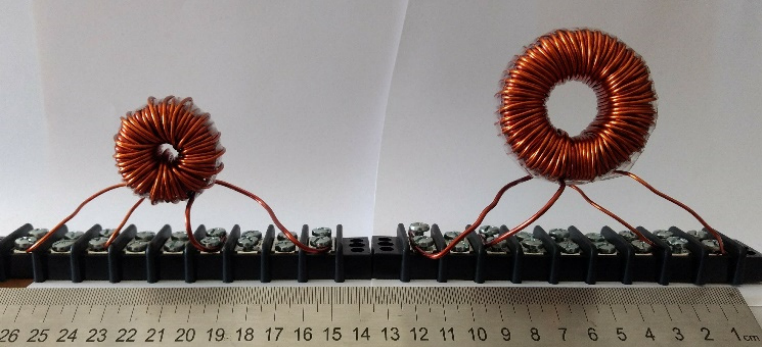
Figure 9. MFTs prototypes featuring: a Nanocrystalline core ( left ), a ferrite core ( right ).